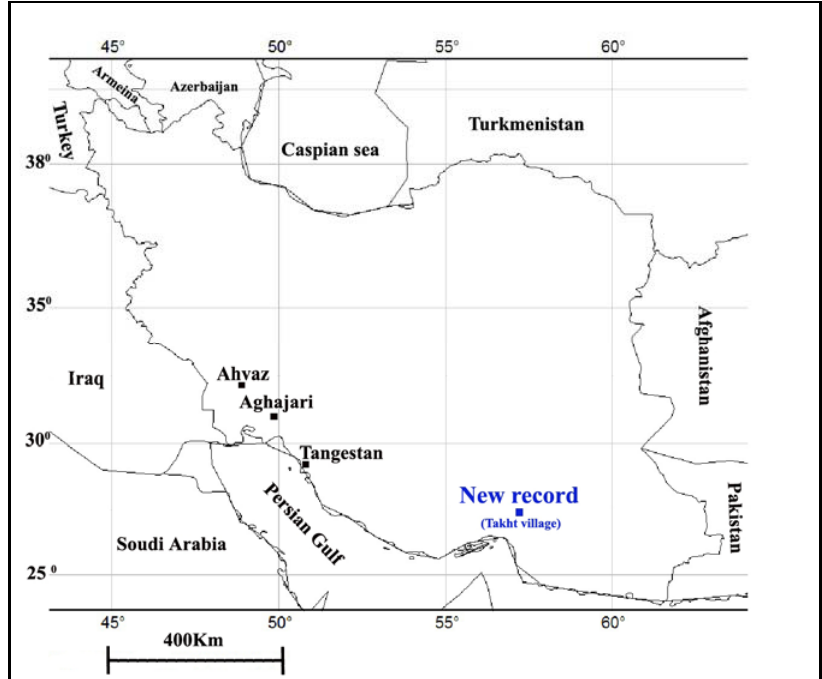
F IGURE 3. Locality of the newly-collected specimen of Stenodactylus affinis (blue rectangle). Note the significant distance from the previous Iranian records (Tangestan, Aghajari,